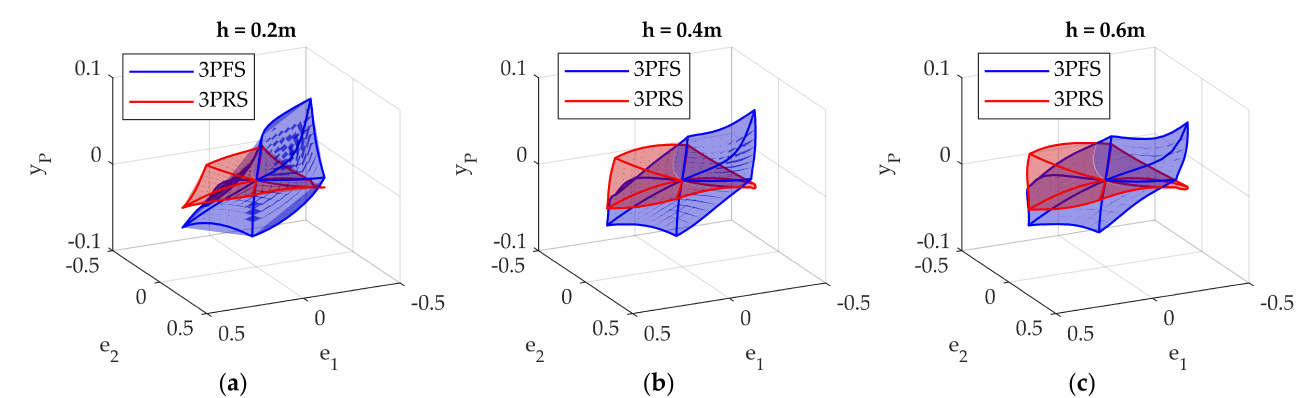
Figure 13. Parasitic motion y P